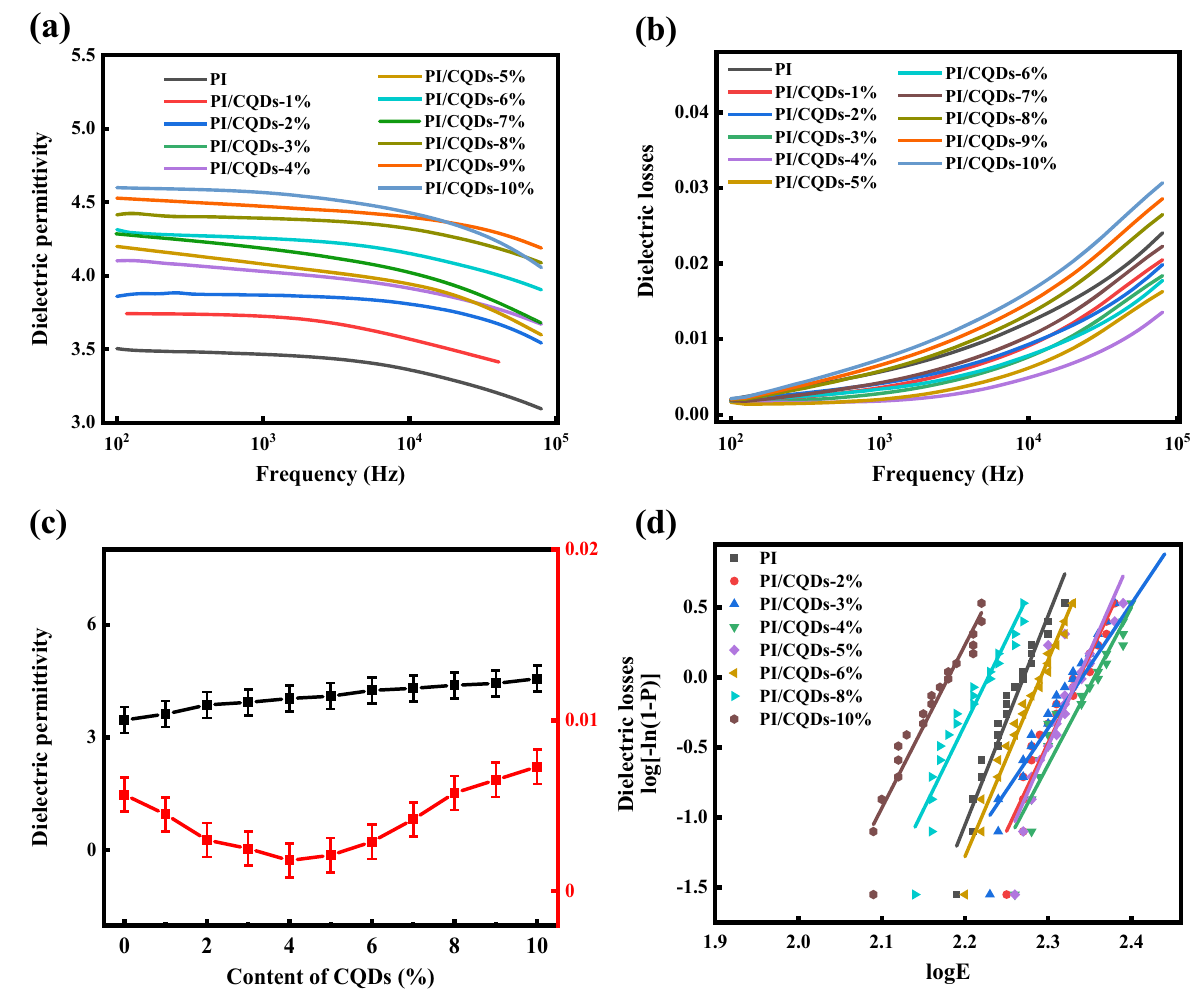
Figure 5: Dielectric property of PI/CQD composites: ( a ) dielectric permittivity at di ff erent frequencies, ( b ) dielectric loss at di ff erent frequencies, ( c ) dielectric property on the weight fraction at 1 kHz, and ( d ) the Weibull distribution of dielectric breakdown